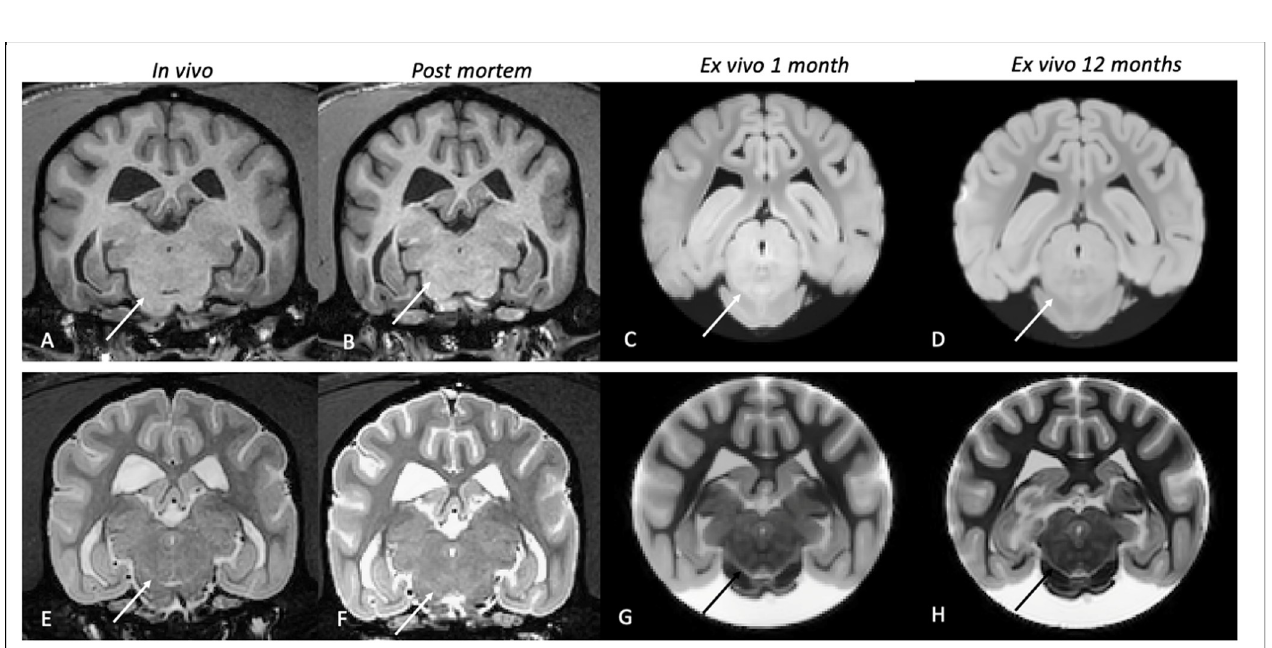
Fig 4. T1 and T2 progressive change of contrast. Panels A-D: T1w transverse section of the studied dog in the four different phases of the experiment, respectively in vivo (A), post mortem (B), ex vivo 1 month (C), and ex vivo 12 months (D). In vivo and post mortem grey and the white matter appeared respectively hypointense and hyperintense, on ex vivo images the contrast appeared exactly the opposite, with grey and white matter respectively hyperintense and hypointense. The solid arrows point at the Substantia Nigra and a progressive increase in contrast can be seen. Panels E-H represent the same four phases from T2w images. Here, rather than an inversion of the normal contrast, a sharp decrease in white matter intensity was observed in the ex-vivo phase. This leads to an increased definition of the contours of the different structures.